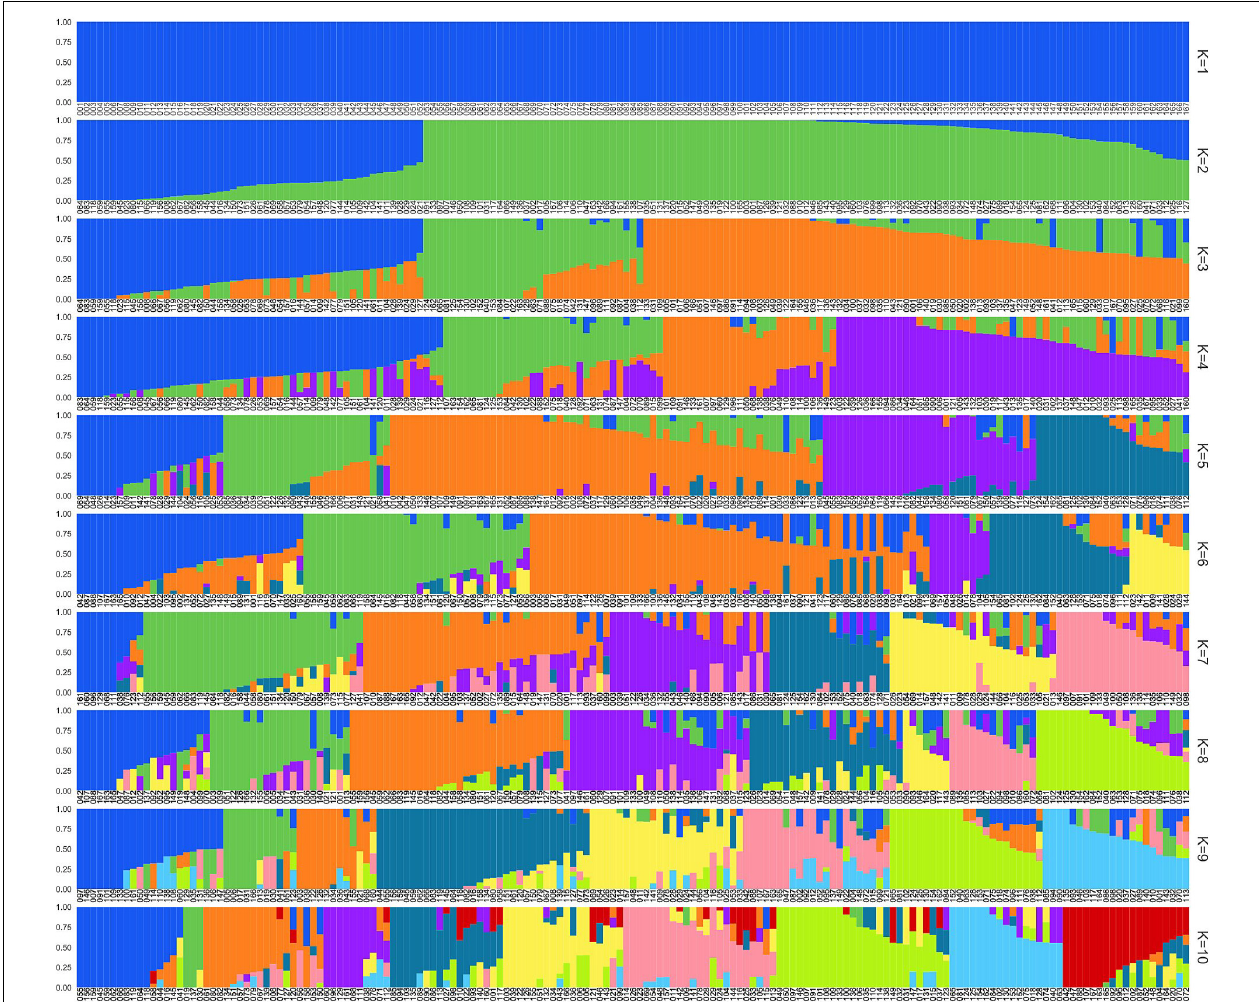
FIGURE 2 | Population structure analysis results from k = 1 to k = 10. ID is described in Supplementary Table 1